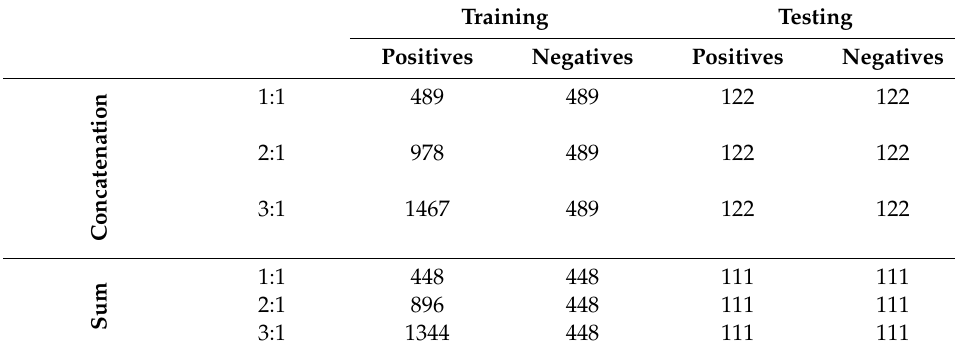
Table 2. Test sets without